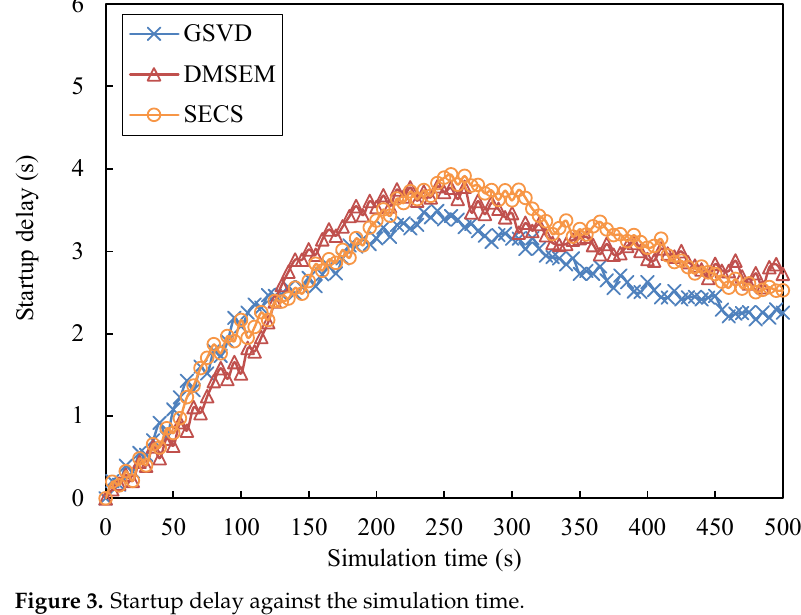
Figure 3. Startup delay against the simulation time.